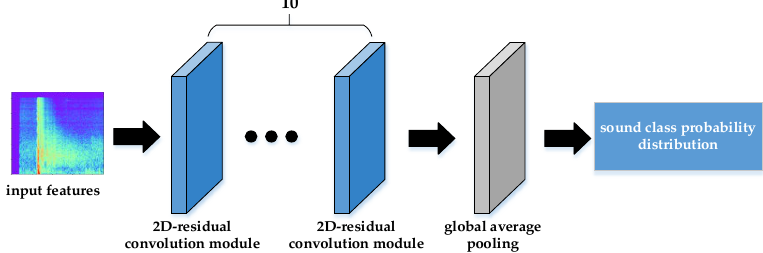
Figure 5. Schematic diagram of the teacher network structure.